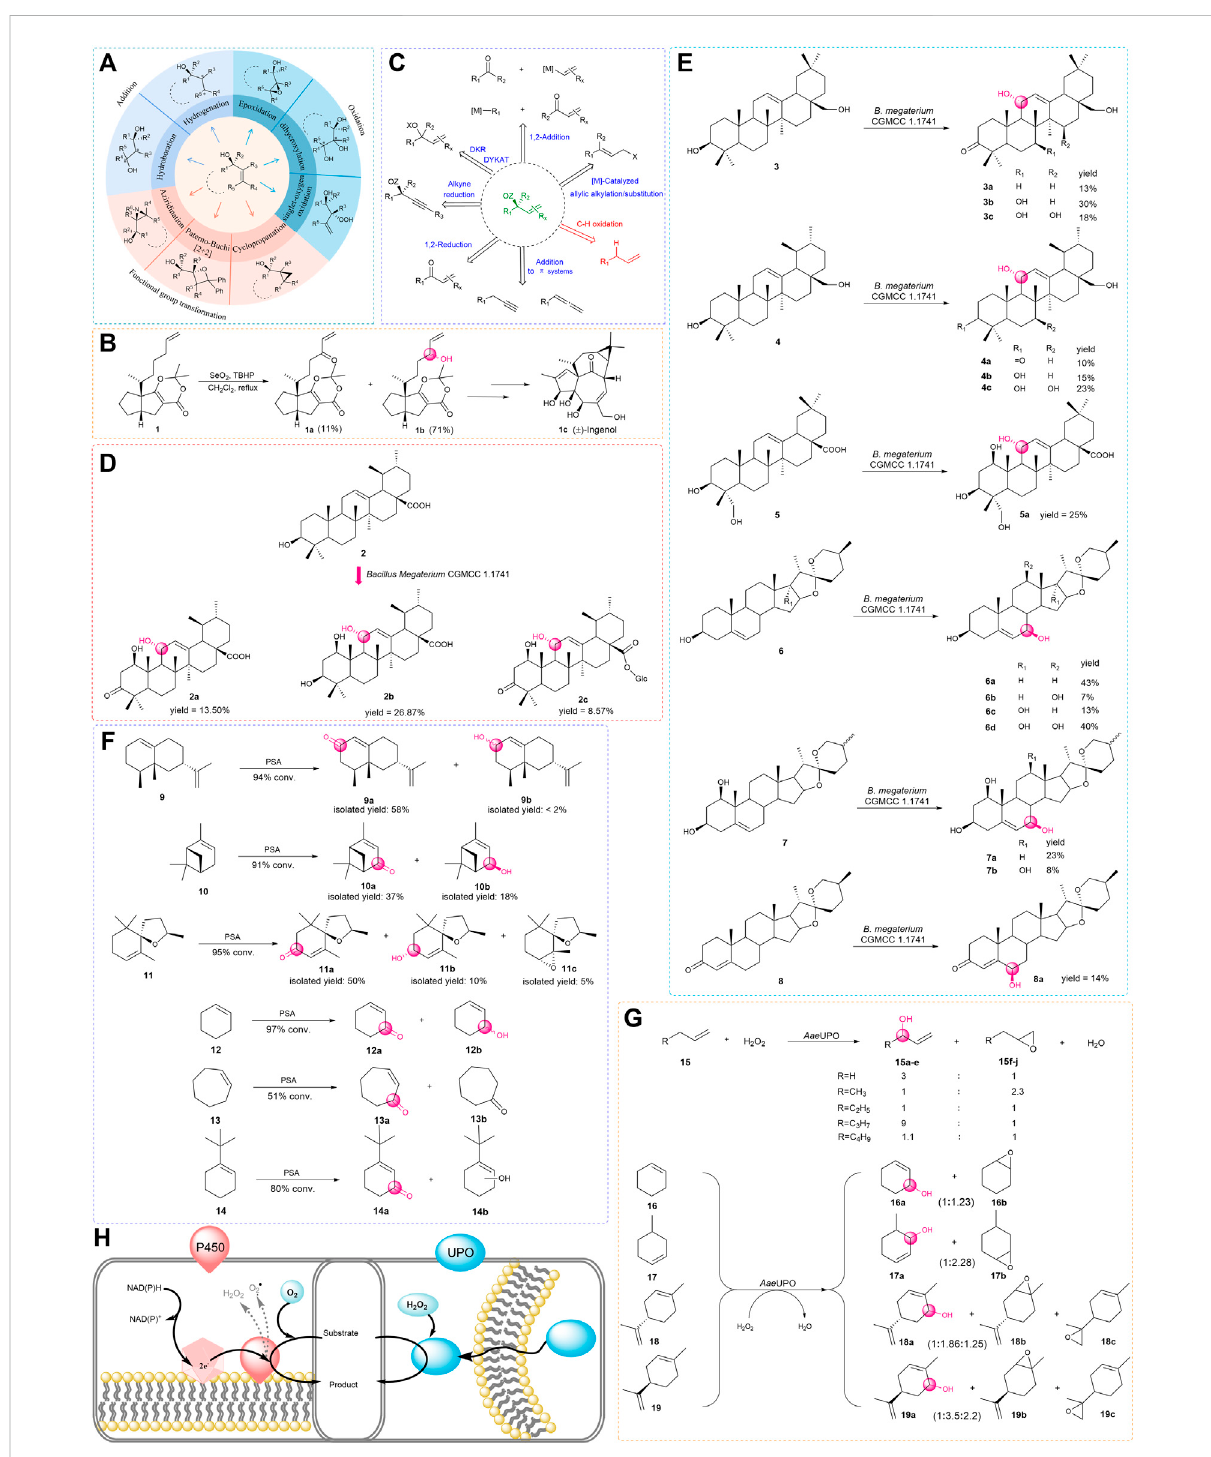
FIGURE 1 (A) Diastereoselectivetransformationsofallylicalcohols. (B) Totalsynthesisof(±)-Ingenol. (C) Catalyticasymmetricaccesstoenantio-enriched allylic alcohols. (D,E) Biotransformation of triterpenes and steroids by Bacillus megaterium . (F) Biocatalytic allylic oxidation by PSA. (G) Epoxidation competes with allylic hydroxylation in most cases. (H) P450s and UPOs are compared. (The red on the left is P450s which rely on auxiliary proteins and cofactors, the blue on the right is UPOs which require only hydrogen